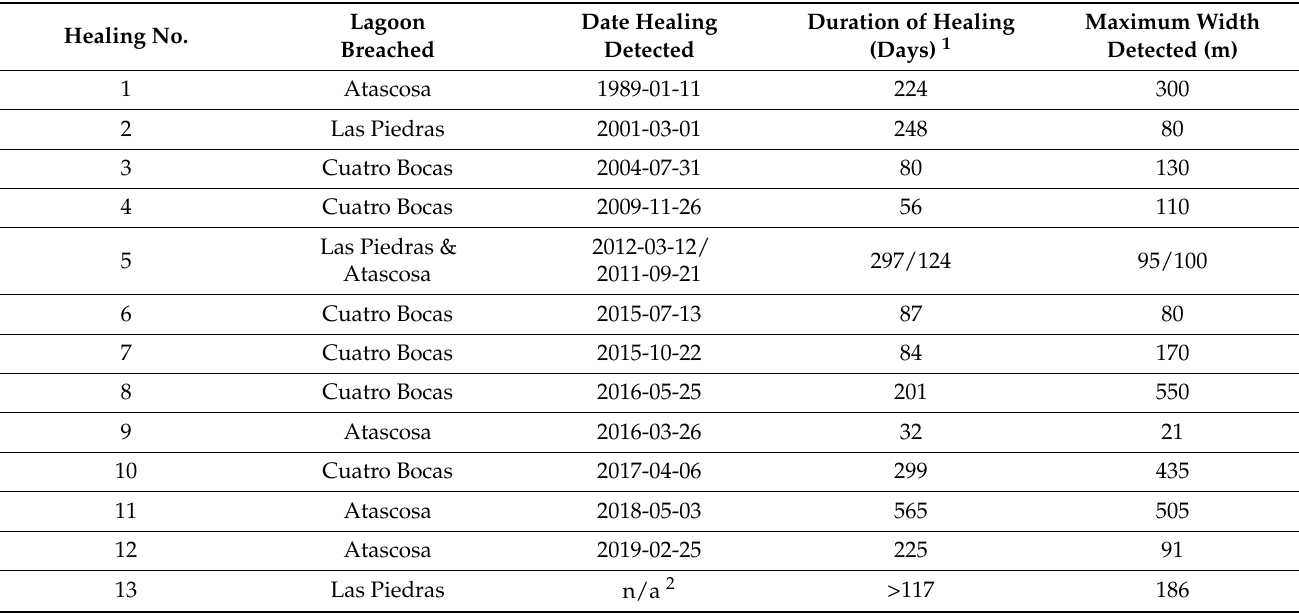
Table 2. Lagoon healing conditions for the period